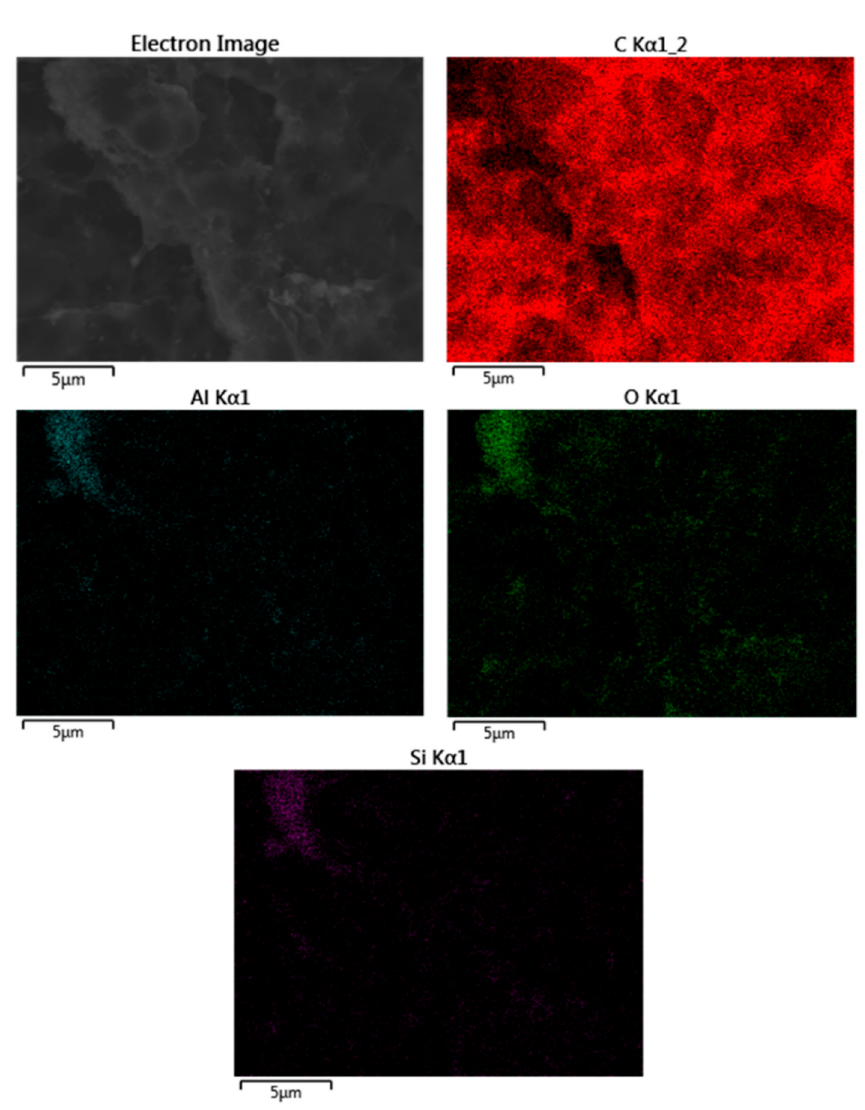
Figure 5. Field emission scanning electron microscopy (FESEM) image of a PLA / HNT composite with 9 wt% HNTs at 5000 × and EDX mapping corresponding to carbon (C K α 1_2), aluminum (Al K α 1), oxygen (O K α 1) and silicon (Si K α 1).